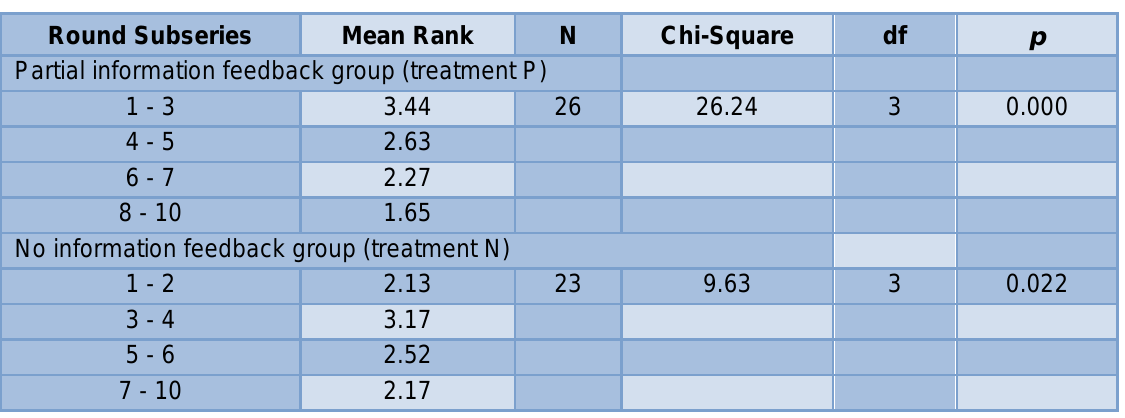
Table 2 Friedman test results for partial and no information feedback